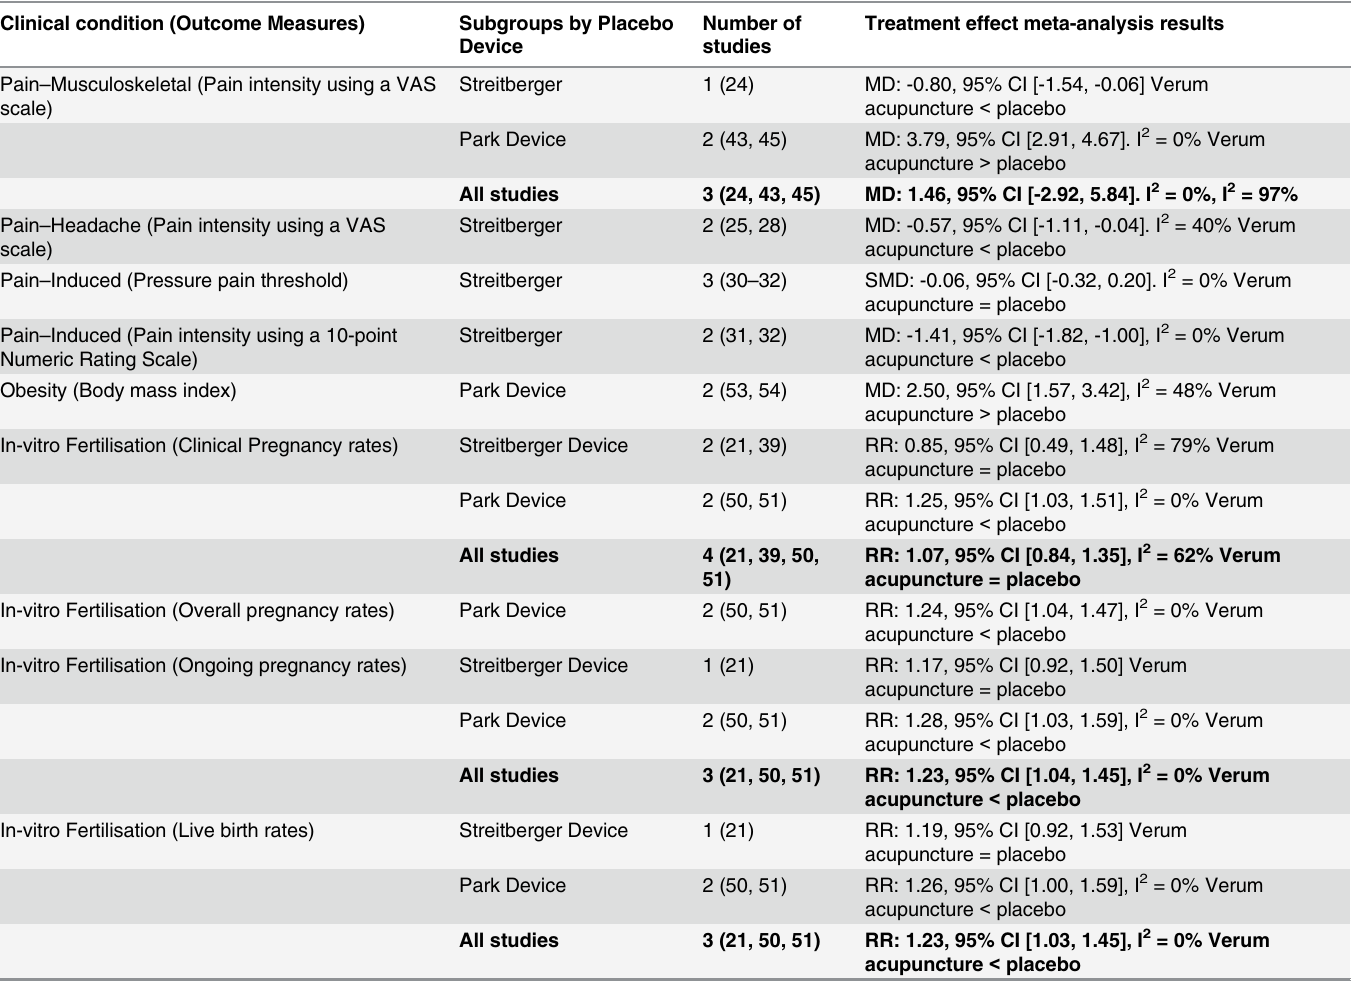
Table 4. Treatment effects of meta-analysis results.